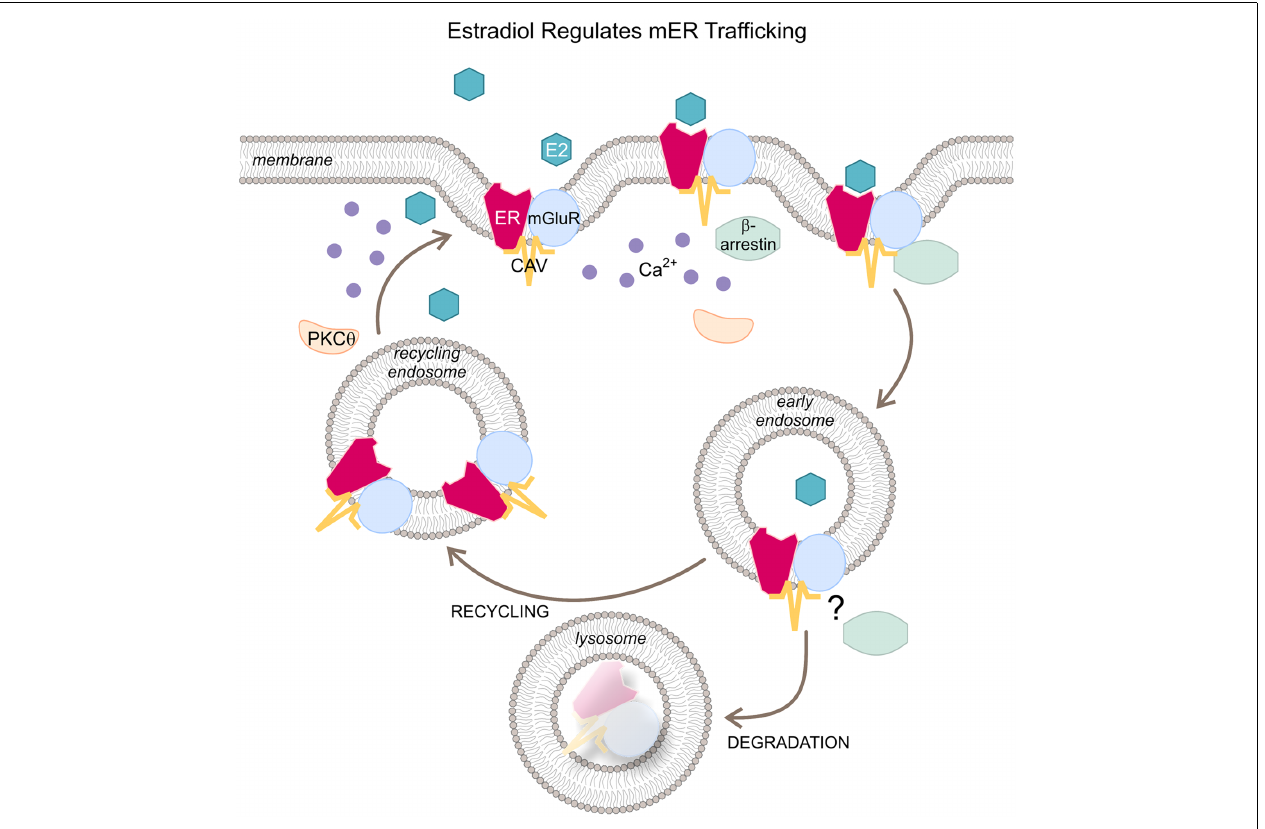
into early endosomes. At this point, the receptor is either dissociated from its agonist and recycled back to the plasma membrane or degraded by fusing with lysosomes. Abbreviations: E2, estradiol; ER, estrogen receptor; CAV, caveolin; mGluR1, metabotropic glutamate receptor 1; PKC θ , protein kinase C θ